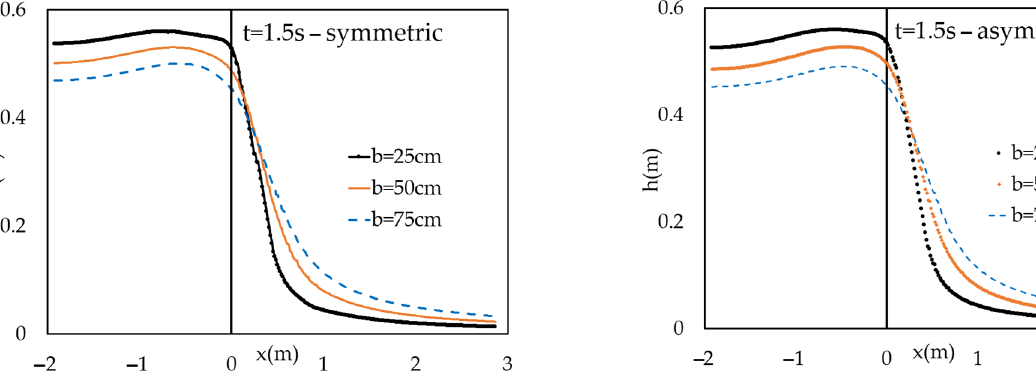
Figure 6. Water depth profiles at central axis of partial dam collapsed.